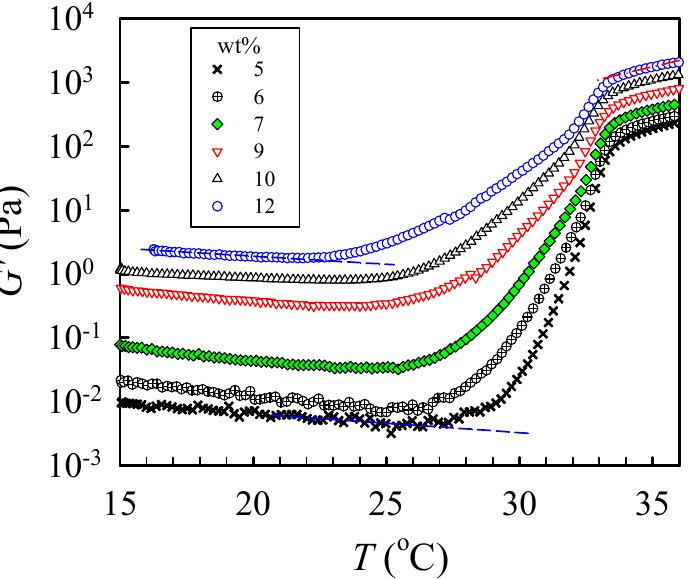
Figure 7. Temperature dependence of the storage modulus G (cid:48) of a-PNIPAM/H 2 O of different concentrations during a temperature sweep test at a heating rate of 0.2 °C/min and applied frequency of 5 rad/s.